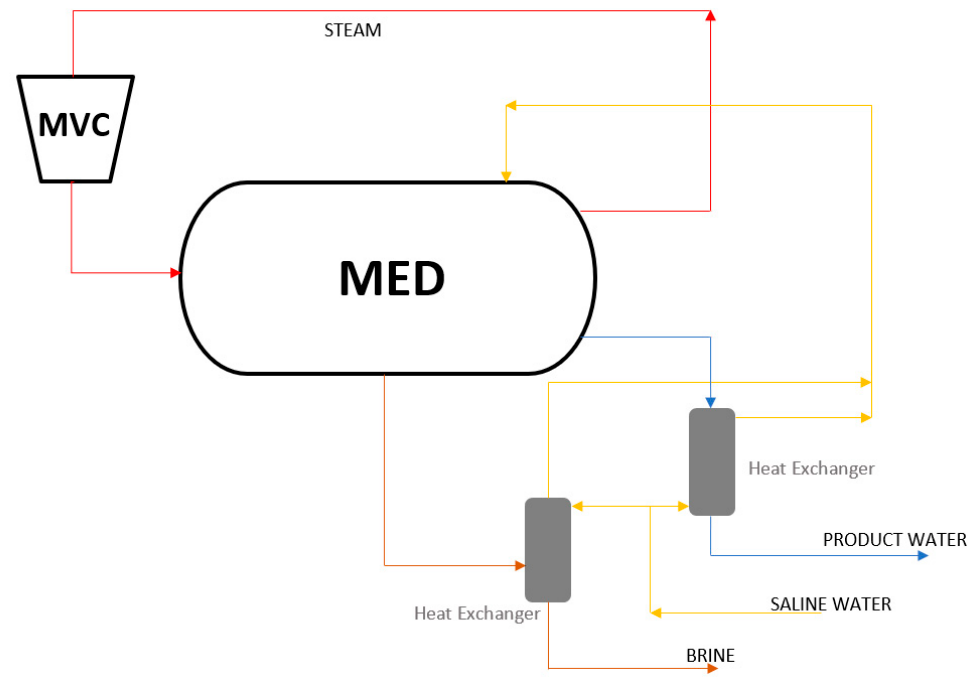
Figure 8. MED–MVC process.